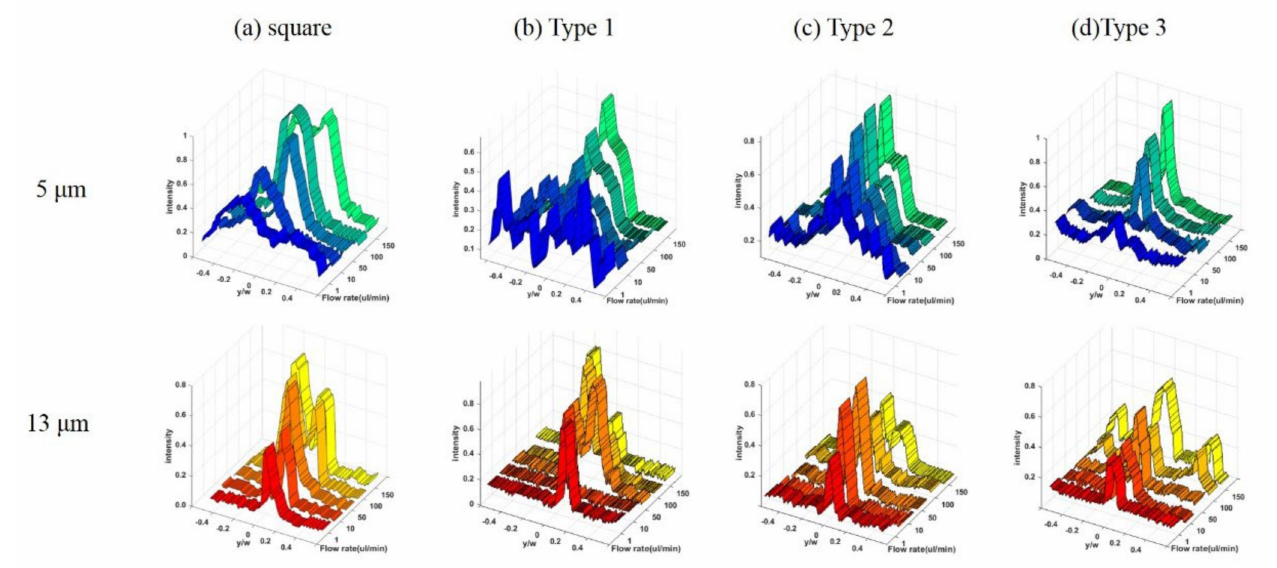
Figure 6. Fluorescence intensity under viscoelastic fluid (top view) for 5 µ m and 13 µ m particles in